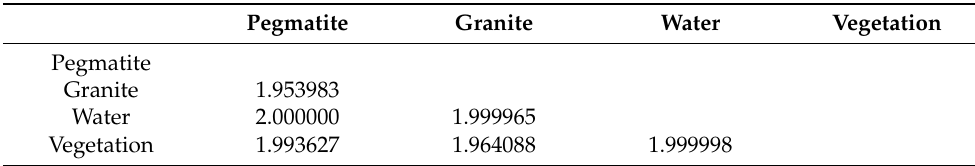
Table 6. Signature separability for training